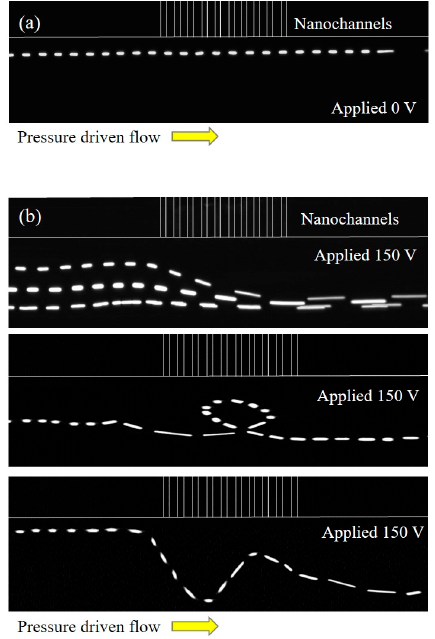
Figure 2. ( a ) Particle path lines with no voltage and ( b ) particle path lines with an applied voltage of 150 V.